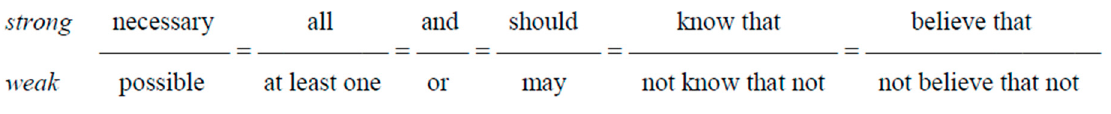
Figure 15. Interpretations of the systems Σ 1 and Σ 2.